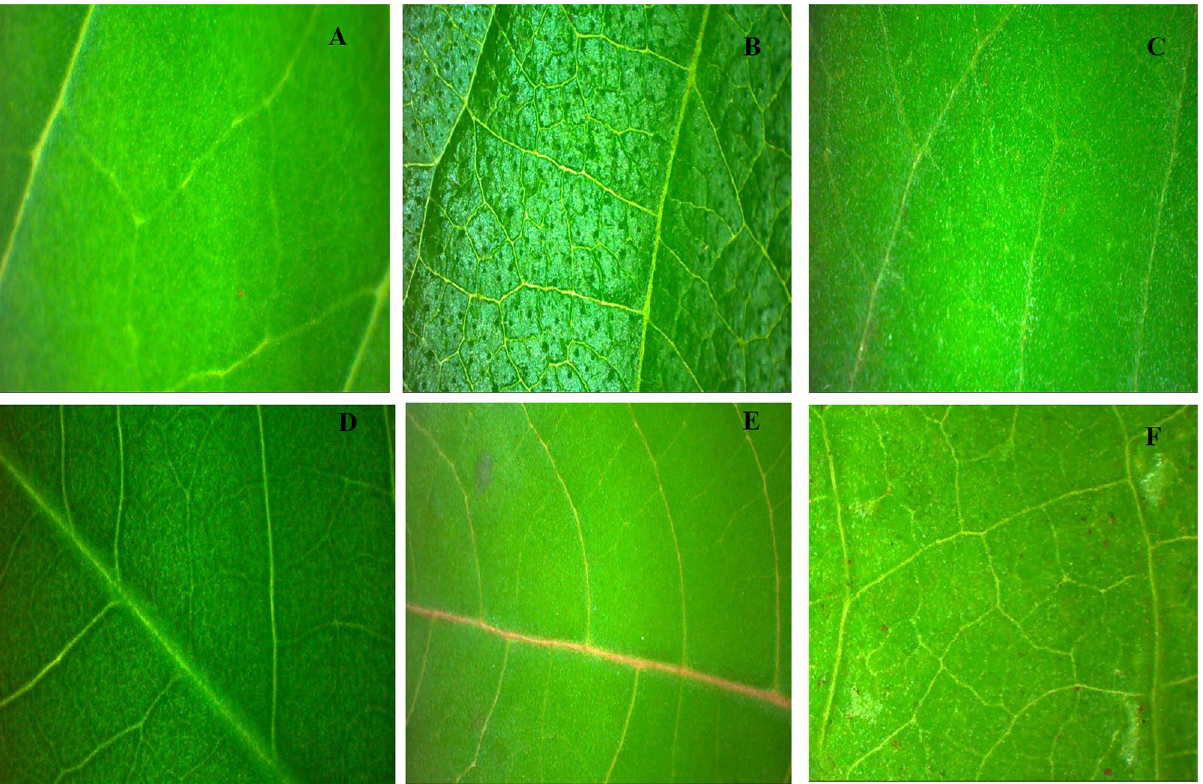
Figure 6. Surface abaxial in plants of the Crotalaria incana L. ( A ), Lantana camara L. ( B ), Asclepias curassavica L. ( C ), Senna obtusifolia (L.) H.S.Irwin & Barneby ( D ), Ricinus communis L. ( E ) and Ipomoea grandifolia (Dammer) O’Donell ( F ) taken on the Stereoscopic Microscope with × of 155.3 L ha −1 , however, at a dose of 310.6 L ha −1 , the spray solution without adjuvant or mineral or vegetable oil showed lower values of contact angle. For the milkweed bloodflower, on the adaxial surface, the sprays solution, doses, interaction, and control treatment were not significant (p = 0.1320, 0.6804, 0.0848, and 0.800, respectively), the abaxial surface, the sprays solution, doses, and interaction were not significant (p = 0.2016, 0.7371 and 0.8916, respectively), so the contact angle values were statistically similar to each other. However, its species presented a lower average value of the contact angle (43.93°) compared to other plants (Fig. 5 and 6). The standard surface (Parafilm) sprays solutions, control treatment and doses were significant (p > 0.0001) but there was no significance for interaction (p = 0.2077), thus, regardless of the dose, the addition of lecithin resulted in the lowest contact angle of the drops. In the weed control experiment, shakeshake and lantana plants showed rapid damage caused by the herbicide aminopyralid + fluroxypyr (Fig. 3 and 4). For shakeshake, at 5 DAP the spray solution and dose were not signifi- cant (p > 0.05), the control treatment versus the treatments and the interaction was significant (p = 0.0019 and 0.0149, respectively), the interaction was significant only in mineral oil in that the level of control was lower at the dose of 155.3 L ha −1 . At 11 DAP the spray solution was not significant (p > 0.05), but the doses, the interaction, and the control treatment versus the treatments were significant (p = 0.0009, 0.0413, and 0.0001, respectively), the interaction was significant because there were differences in lecithin at the control level, in which the dose of 155.3 L ha −1 resulted in the lowest level of control. In the last evaluation at 16 DAP, the spray solution was not significant (p > 0.05), dose, interaction, and control versus treatments were significant (p = 0.0001, 0.0353 and 0.001), the interaction was significant for the spray solutions that had the addition of an adjuvant, in which the highest level of control was observed at the dose of 310.6 L ha −1 (Fig. 3 and 4). The level of lantana control at 5 DAP showed significance for spray solution (p = 0.0257) and control versus treatments (0.007), the dose and interaction were not significant (p > 0.05), at 11DAP the spray solution, dose, and interaction were not significant (p = 0.1377, 0.0706 and 0.6540, respectively) there was only significance for control versus treatments (p = 0.0001). At 16 DAP the spray solution, dose, and interaction were not significant (p = 0.4703, 0.1734, and 0.4210, respectively), there was significance for the control versus treatments (p = 0.0004) (Fig. 3 and 4). In general, at 5 DAP, both species showed symptoms of twisting of the leaves next of the apical region was observed differences between treatments with no adjuvant and the doses used. The dose of 310.6 L ha −1 showed a better percentage of control in both species, and independent of the treatments used (Fig. 3 and 4).